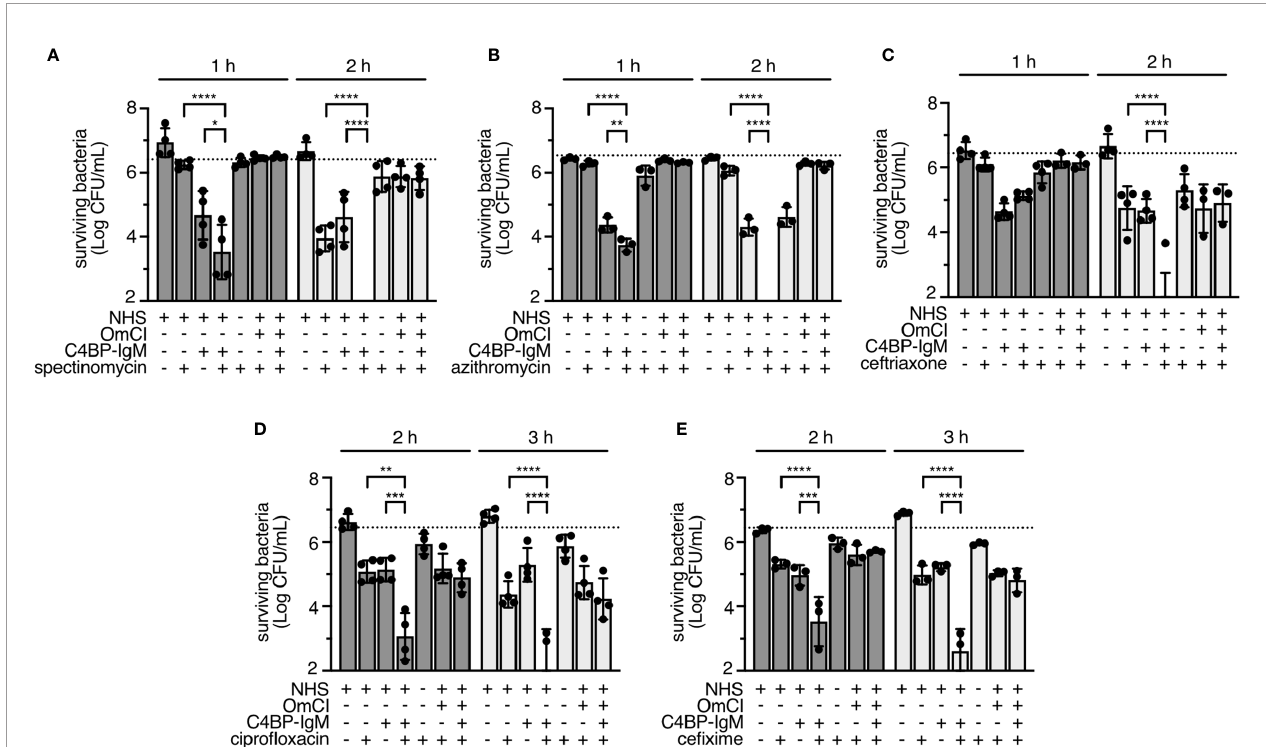
FIGURE 2 | NHS and C4BP-IgM potentiates antibiotic killing of N. gonorrhoeae FA1090. (A – E) FA1090 gonococci were incubated for 1, 2 or 3 hours with 10% NHS+/-OmCI supplemented with antibiotics (spectinomycin 32 m g/mL, azithromycin 250 ng/mL, ceftriaxone 50 ng/mL, cipro fl oxacin 3.75 ng/mL, ce fi xime 12.5 ng/ mL) in the presence or in the absence of 5 m g/mL of C4BP-IgM. Differences among samples were compared using two-way ANOVA with Tukey´s multiple comparison test. Bars display mean+/-SD, with circles indicating 4 (A, C, D) or 3 (B, E) independent repeats. Horizontal dotted line indicates the starting CFUs of bacteria used in the assay. *p < 0.05, **p < 0.01, ***p < 0.005, ****p <